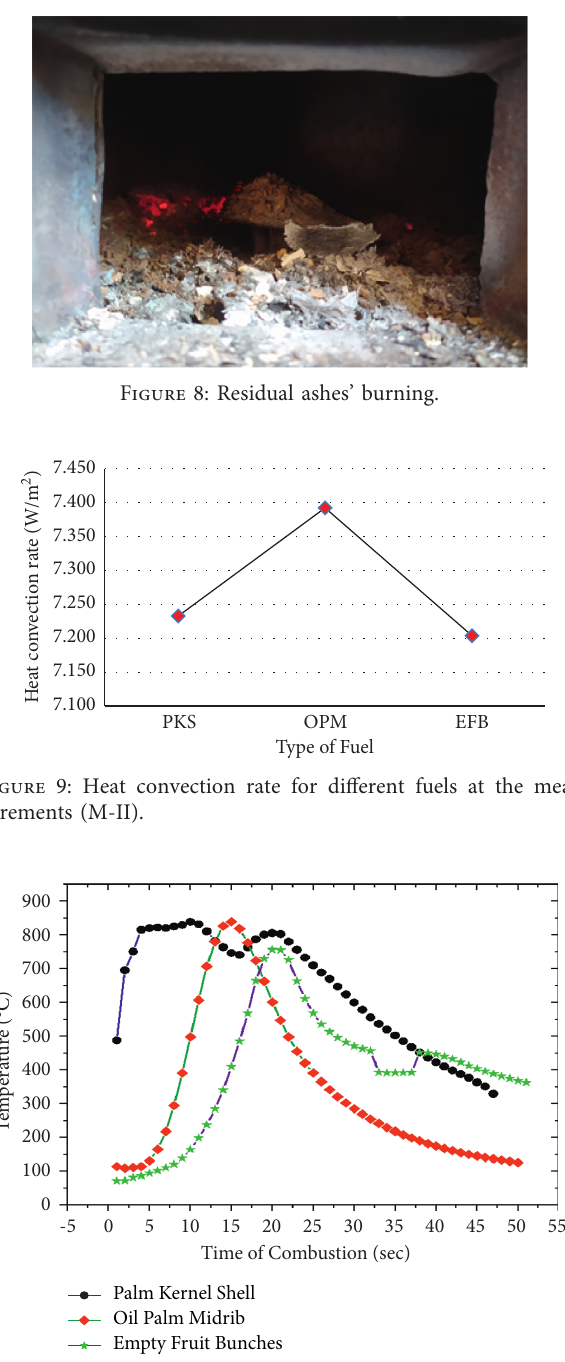
Figure 10: Profile temperature for different fuels at the mea- surement (M-II).